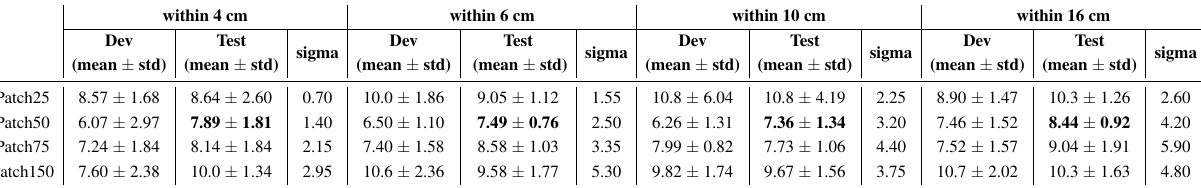
Table A6. HTERs (%) of GLOH features (overlap, PCA 95%).